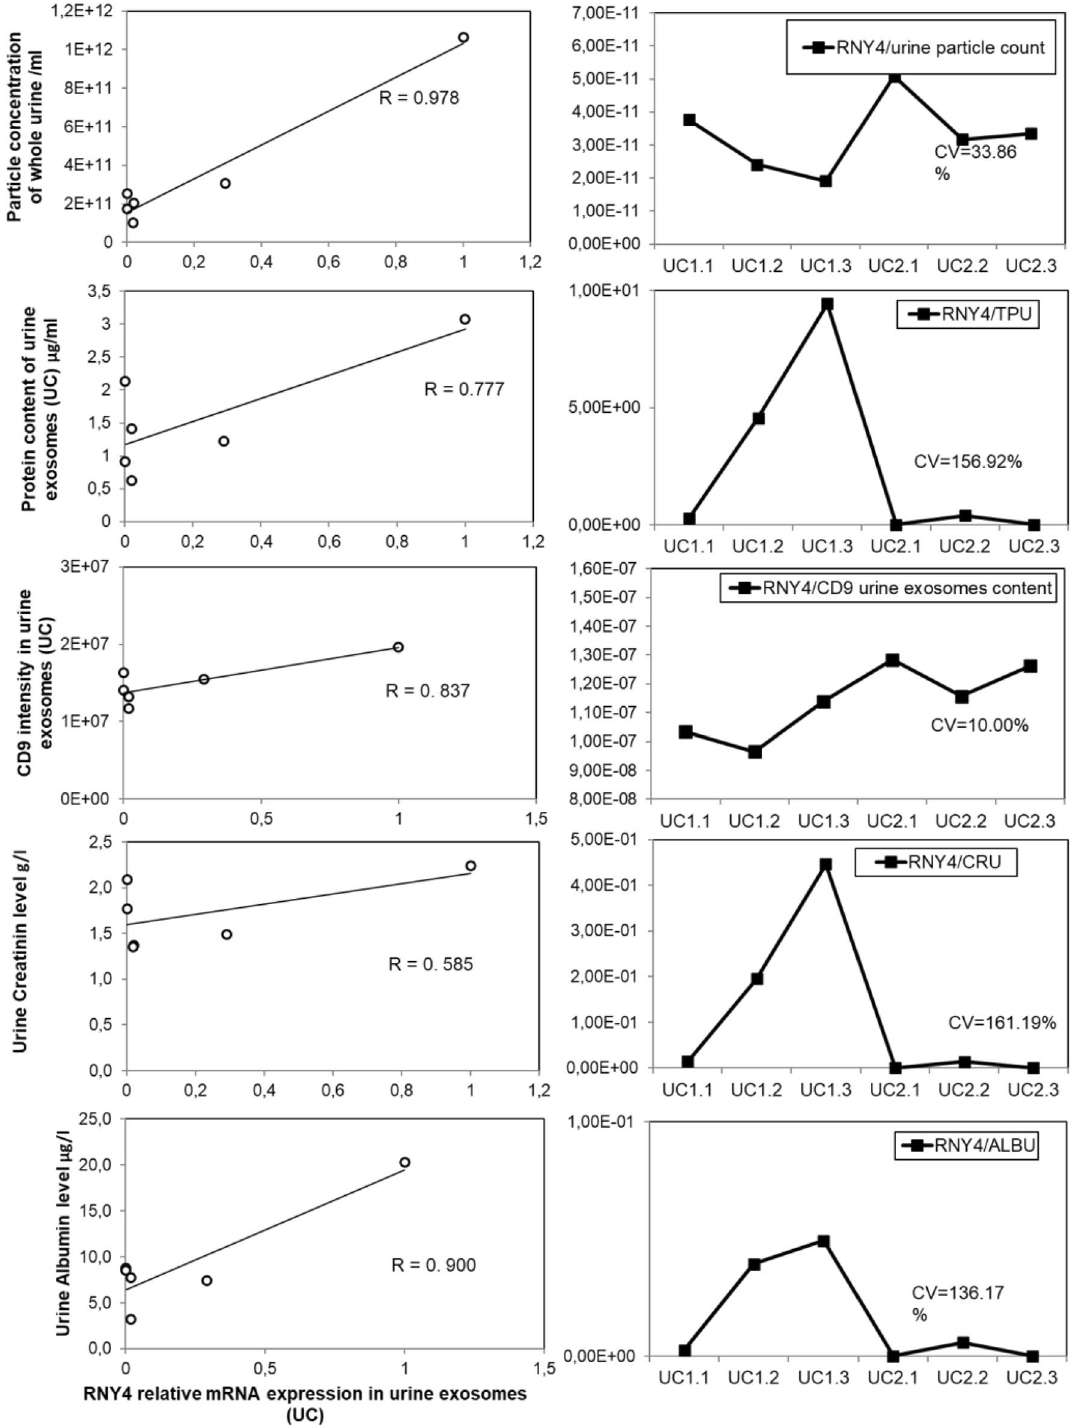
Figure 9. Normalization of EV-RNA content variations to urine biochemical parameters and EV number and protein content. RV RNY4 RNA expression levels across the longitudinal urine samples were first plotted against selected urine biochemical parameters, namely urinary creatinine, albumin and total protein content, as well as against independent EV content indicators, such as particle number measured in the whole urine and the CD9 signal measured in the respective EV isolates (on the left). The same parameters were subsequently used in the attempt to normalize/compensate for variations in EV RNA signals across the samples, revealed as decrease in coefficient of variation (CV, on the right). EVs (UC) were purified by differential (ultra)centrifugation-based protocol from urine obtained from two healthy volunteers, one female (marked as 1) and one male (marked as 2), 45 and 43 years old, in 3 subsequent days. The experimental points are indicated at the x axis of the right panel. The indicators shown on the relative y axis are matched between left and right